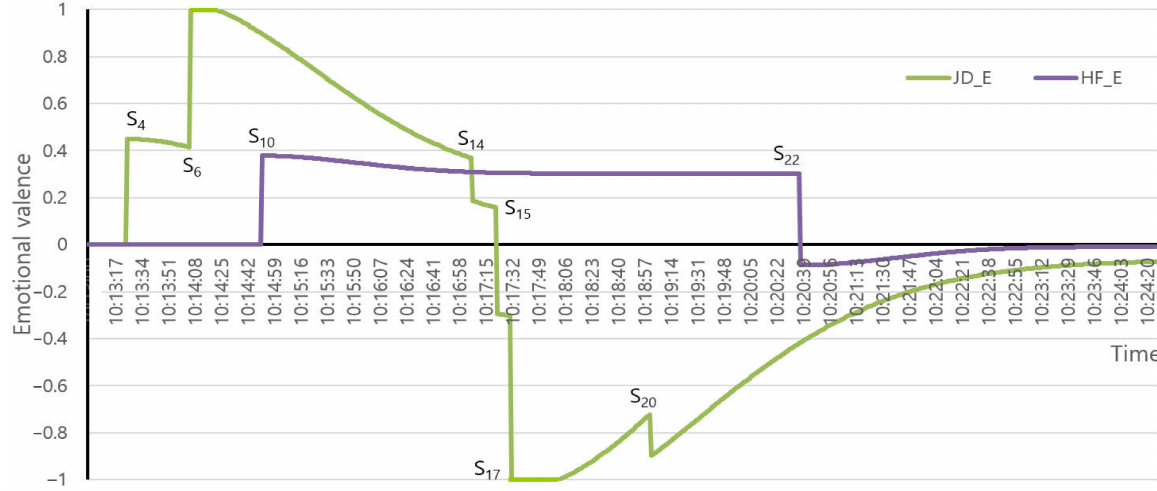
Figure 10. The variation of emotion appraisal toward the